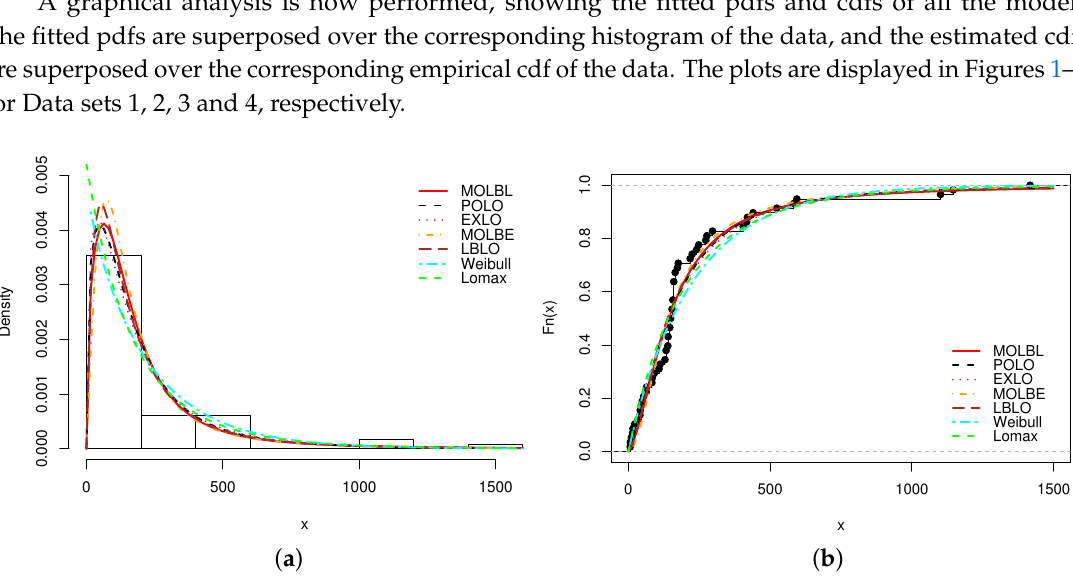
Figure 1. Plots of ( a ) estimated probability density function (pdf) and ( b ) estimated cumulative distribution function (cdf) of the MOLBL model with those of the other competitive models for Data set 1.